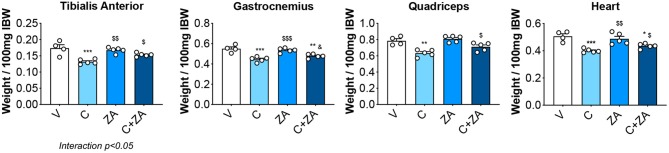
Skeletal muscle mass is partially preserved in the mice treated with C+ZA. Skeletal muscle and heart weights in mice administered C, alone or combined with ZA (n = 4–5). Weights were normalized to the Initial Body Weight (IBW) and expressed as weight/100 mg IBW. Data are expressed as means ± SEM. Significance of the differences: *p < 0.05, **p < 0.01, ***p < 0.001 vs. V; $p < 0.05, $$p < 0.01, $$$p < 0.001 vs. C; &p < 0.05 vs. ZA.